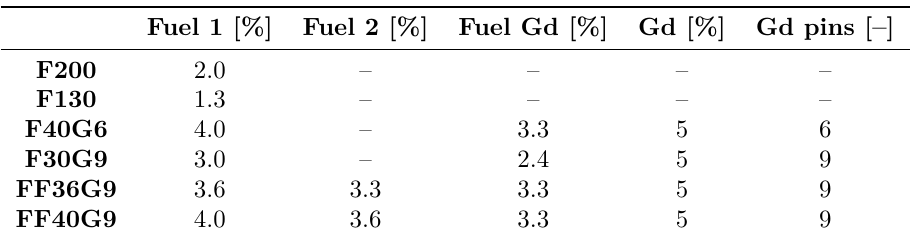
Table 1. Fuel enrichment description.